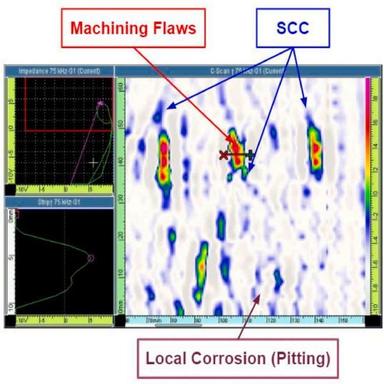
Detection of different kinds of flaws including machinig, general corrosion, pitting and SCC with the advantage of scanning in ECA